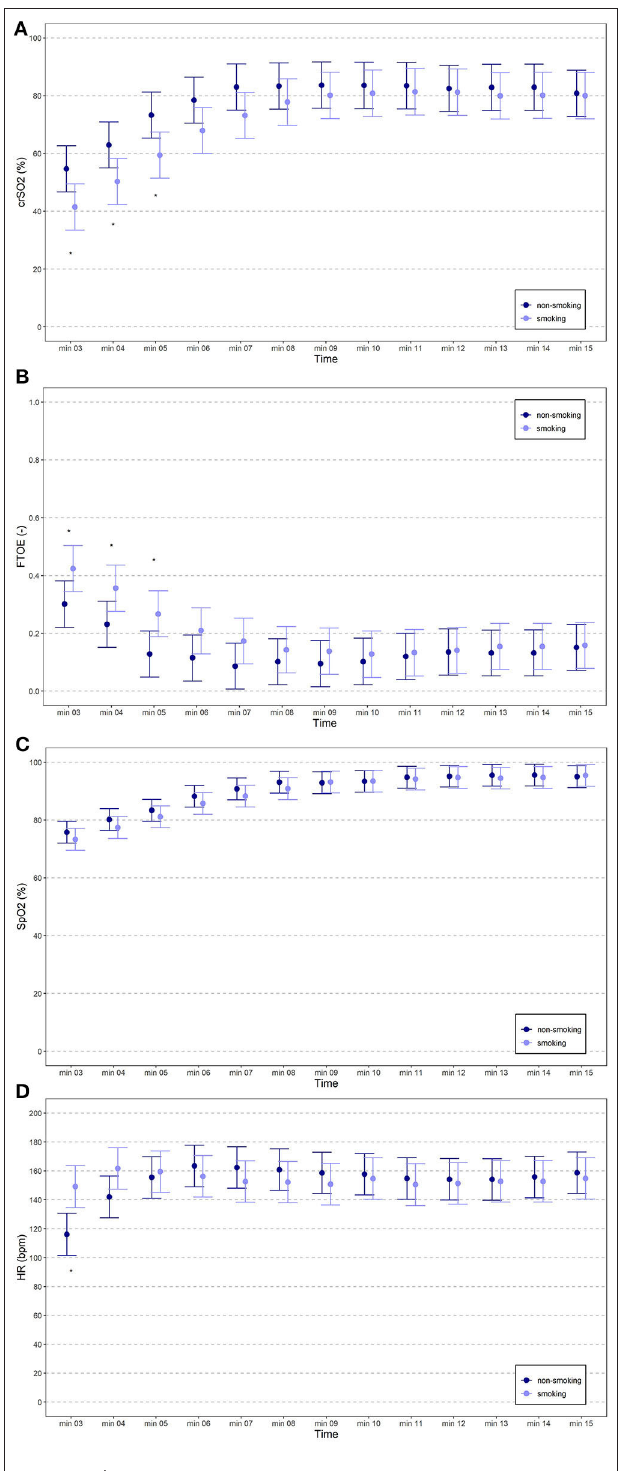
FIGURE 2 | (A–D) crSO 2 , cFTOE, SpO 2 and HR of term neonates from mothers who had smoked during pregnancy (light blue spots) compared to term neonates from mothers who had not smoked during pregnancy (dark blue